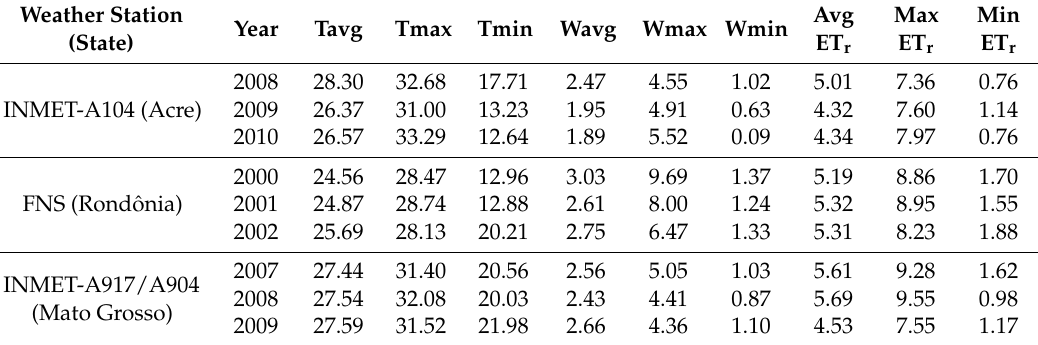
Table 2. Summary of air temperature, wind speed, and reference ET for the study period.